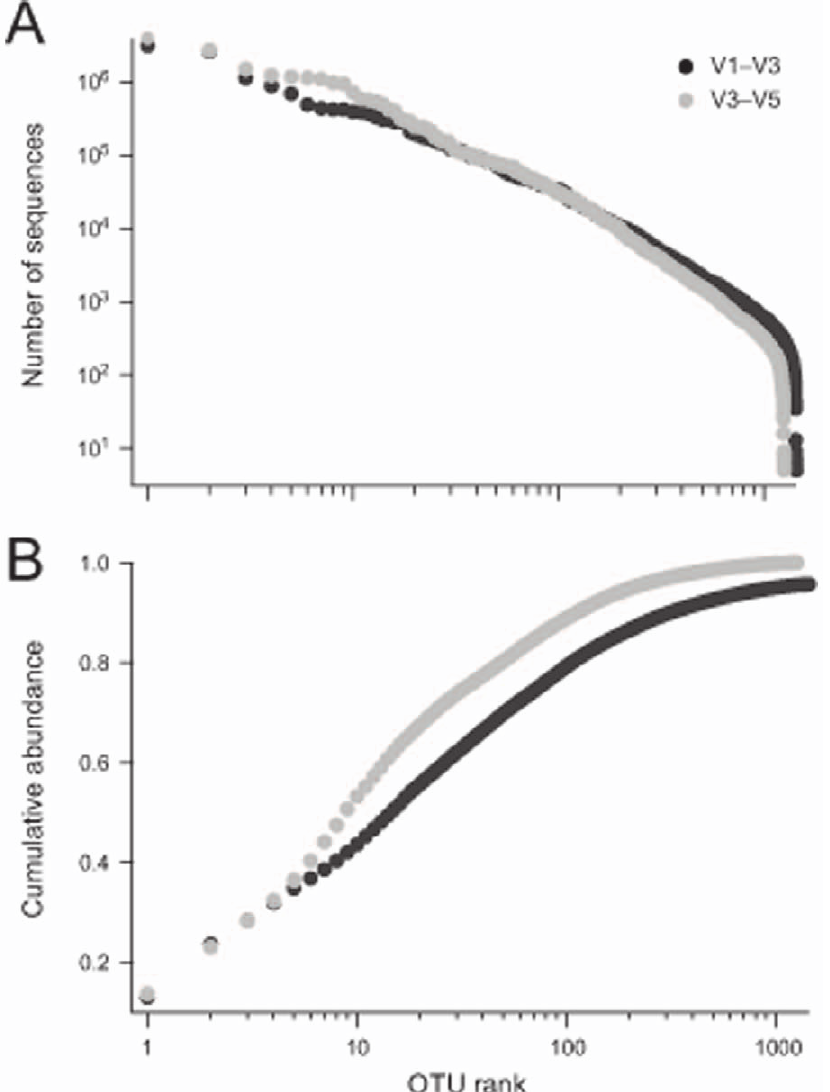
Figure 1. Rank Abundance curves for V1–V3 (black symbols) and V3–V5 (gray symbols) OTUs. (A) The number of sequences in each OTU. (B) Cumulative rank abundance. For both V1–V3 and V3–V5, on the order of 10–15 OTUs captured half of all individual sequences.